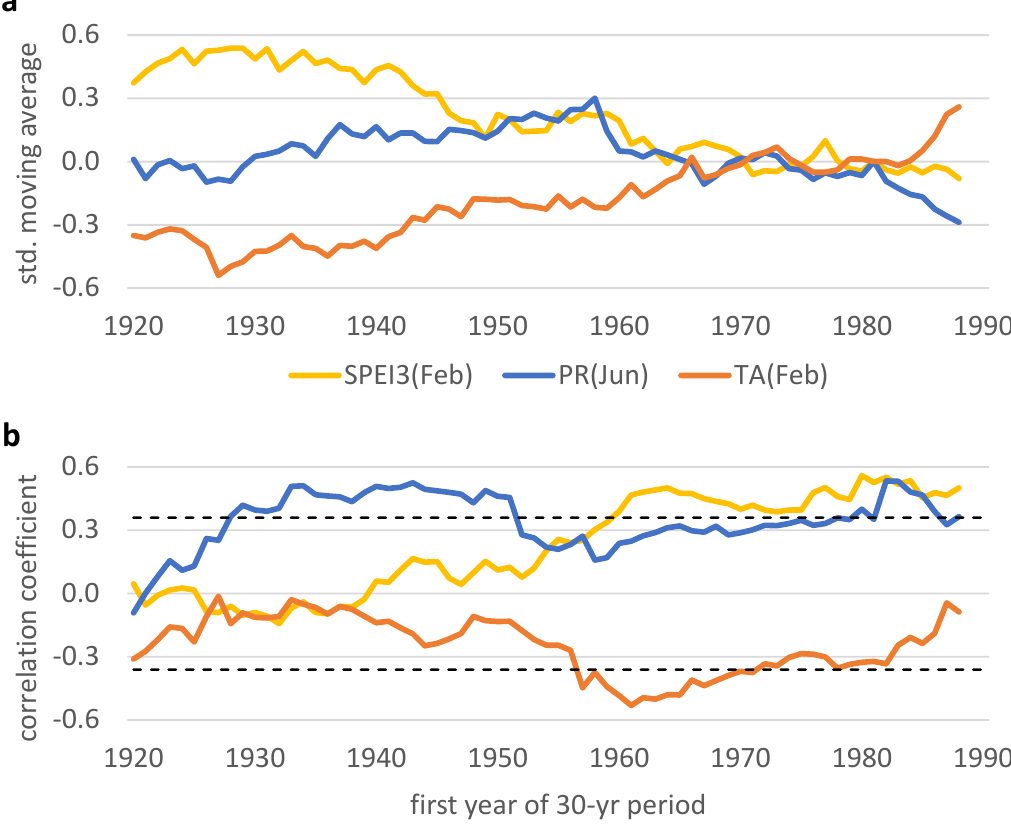
Figure 6. Standardized 30-year moving average trends relative to the period 1981–2010 for the selected climatic variables of PR in June (blue), and TA (orange) and SPEI3 (yellow) in February, for the period 1920–2017 ( a ). Running correlation coefficients for moving 30-year windows between TRWI series and the same climatic variables are plotted for the same period ( b ). Horizontal axes show the first year of the moving 30-year windows; dashed black lines correspond to the significance level of p < 0.1.